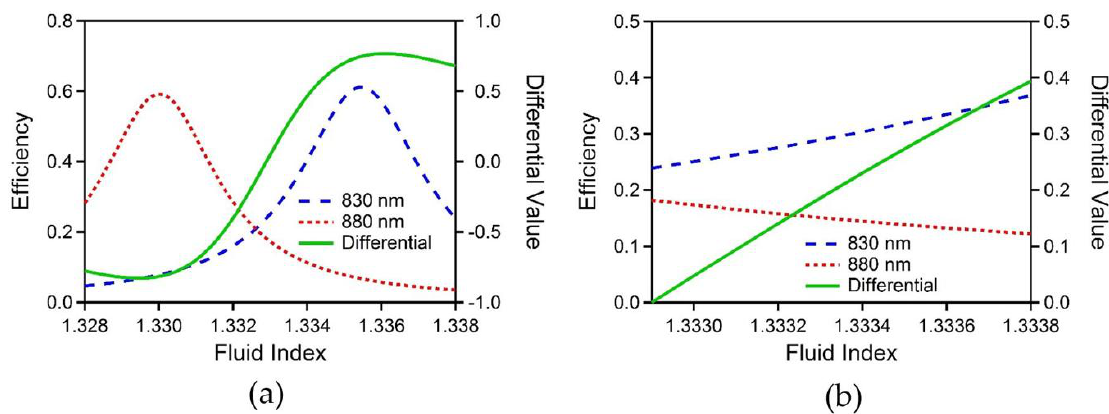
Figure 2. ( a ) Simulation results showing efficiencies of 830 nm (blue dashed line) and 880 nm (red dotted line) and differential value (green solid line) versus the refractive index inside the optical cavity in the range between 1.328 and 1.338. ( b ) Simulation results as shown in Figure 2a with the range of refractive index between 1.3329 and 1.3338.